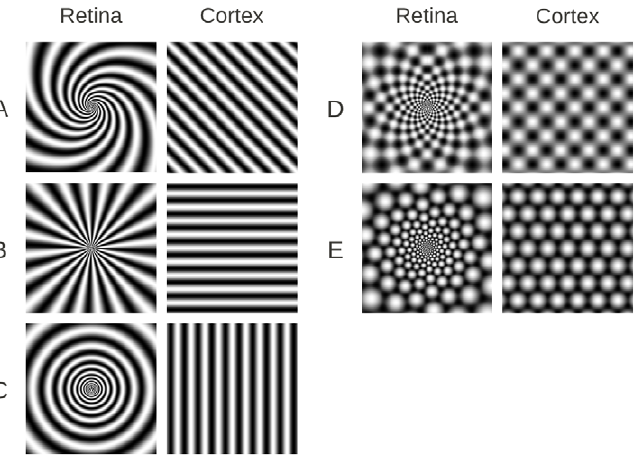
Figure 1. Illustrations of basic phosphene patterns and their transformation to ‘‘cortical coordinates.’’